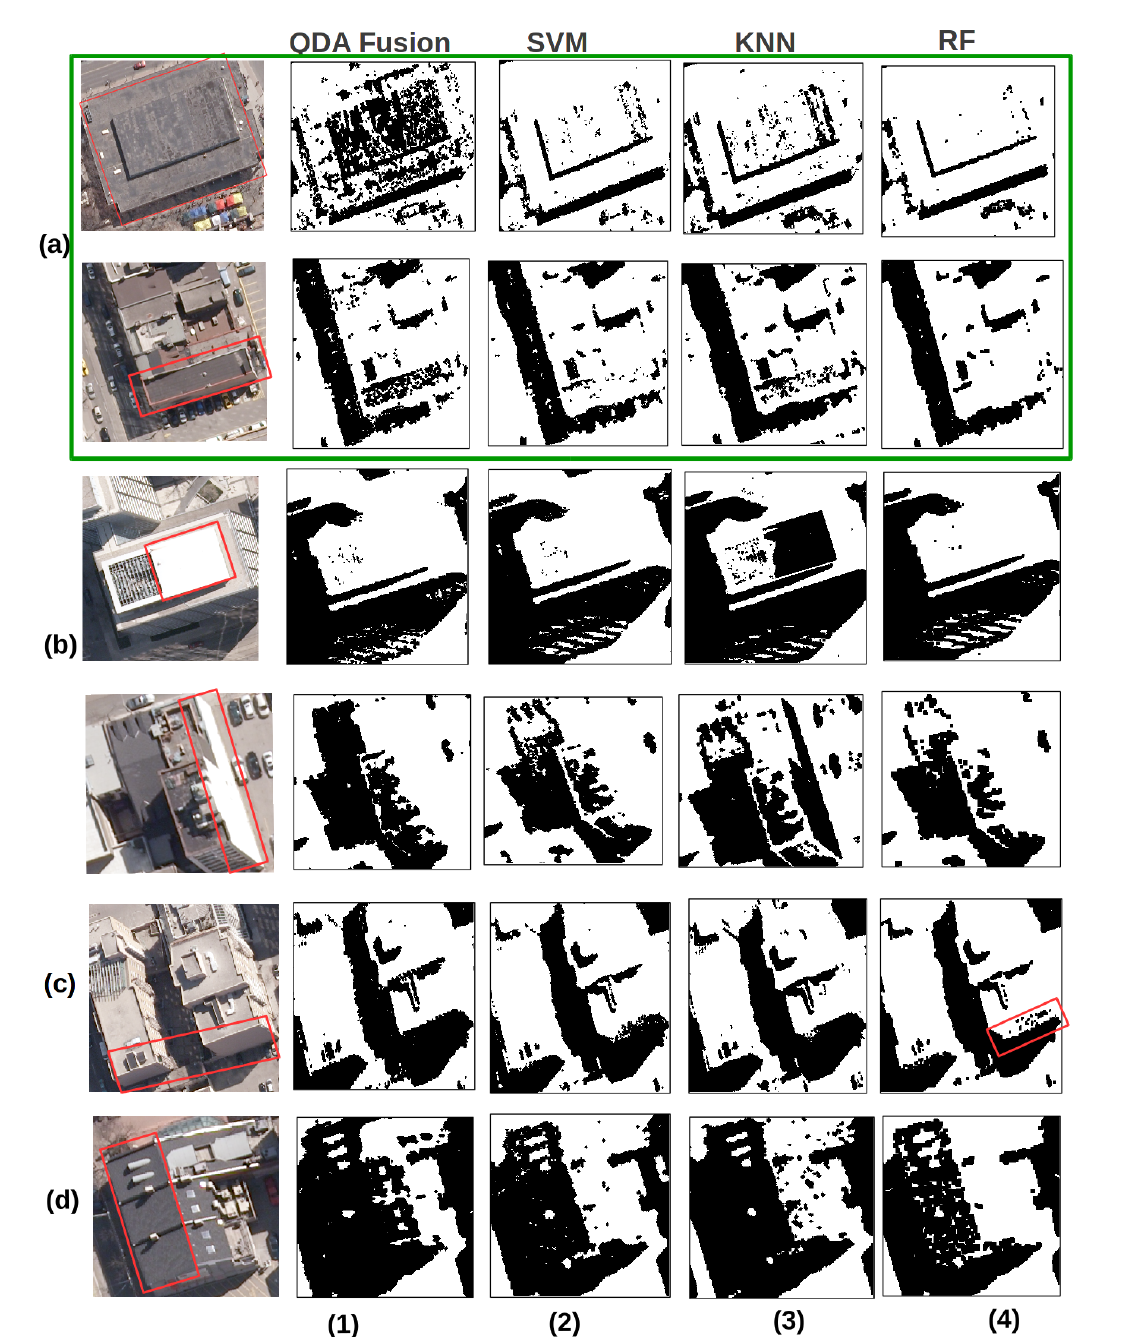
Figure 10. Results of four methods (1)QDA with fusion; (2) SVM with rbf kernal; (3) KNN; (4) RF for difficult cases: ( a ) two building with dark roofs. ( b ) two buildings with a bright and white roof and facade, respectively. ( c ) a building with a bright facade under the shadow. ( d ) a dark roof under the sun is misclassified by all methods due to shading effects. The locations of these buildings are indicated in Figure 2. The results of property methods for the two cases in the green box are shown in Figure